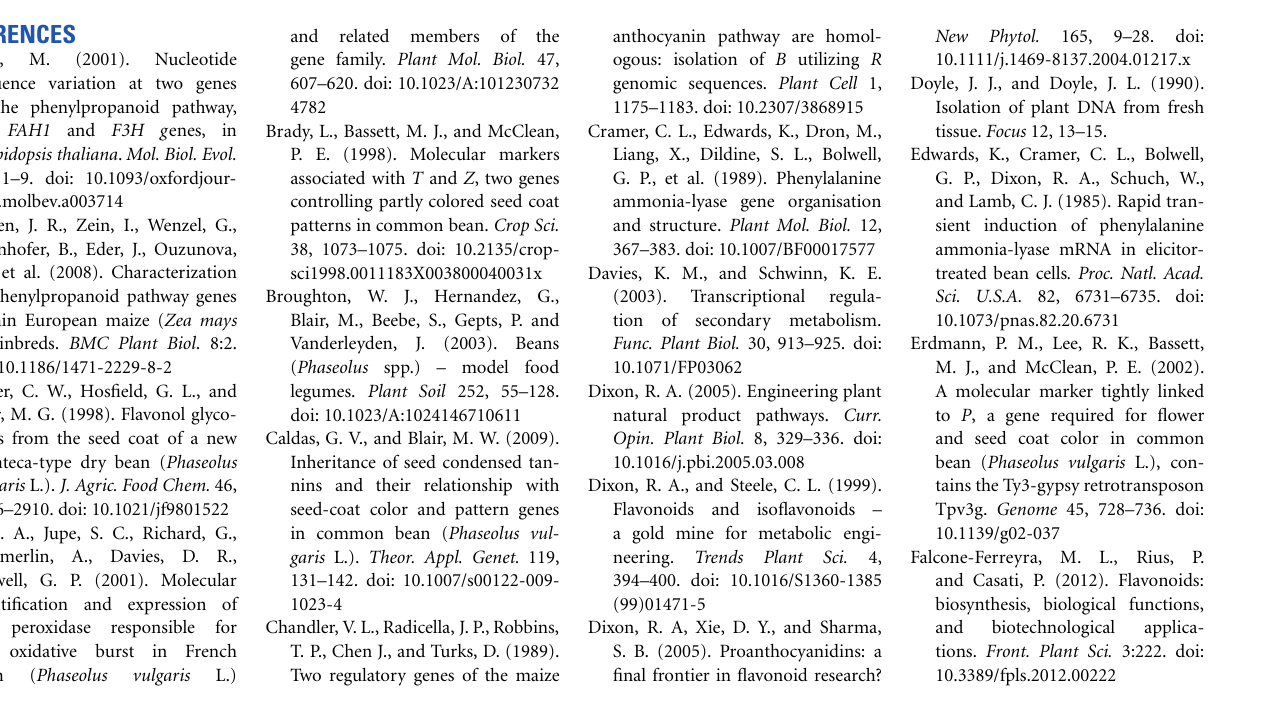
FIGURE S1 | Phylogenetic relationships among common bean and soybean 4CL homologous proteins. Trees were generated from 4CL protein sequence analyses in CLC Genomics Workbench 3 using Neigbor Joining (NJ) algorithm and 1000 bootstrap replications. Scale represents genetic distance and node numbers indicate bootstrap support values. (A) Primary transcripts (98 protein sequences); (B) Twenty-one 4CL proteins selected based on similarity to soybean 4CL1 (red), 4CL2 (blue) and 4CL3/4CL4 (green). FIGURE S2 | Nucleotide sequence comparison of eight 4CL loci (A-H) between Andean common bean landrace G19833 (reference) and Mesoamerican cultivar OAC Rex. Genomic sequences were aligned in ClustalW at EBI. Polymorphic sites (SNPs/indels) are indicated (G19833-blue, OAC Rex-red). FIGURE S3 | Comparison of G19833 (Andean) and OAC Rex (Mesoamerican) 4CL amino acid sequences. G19833 and OAC Rex 4CL sequences are aligned in ClustalW at EBI. Positions of conserved features (NCBI) in aligned proteins are indicated. Table S1 | Common bean phenylpropanoid pathway gene sequence-based in silico map. Table S2 | Soybean phenylpropanoid pathway gene sequence-based in silico map. Table S3 | Exon/intron structure of selected 4CL genes in common bean and